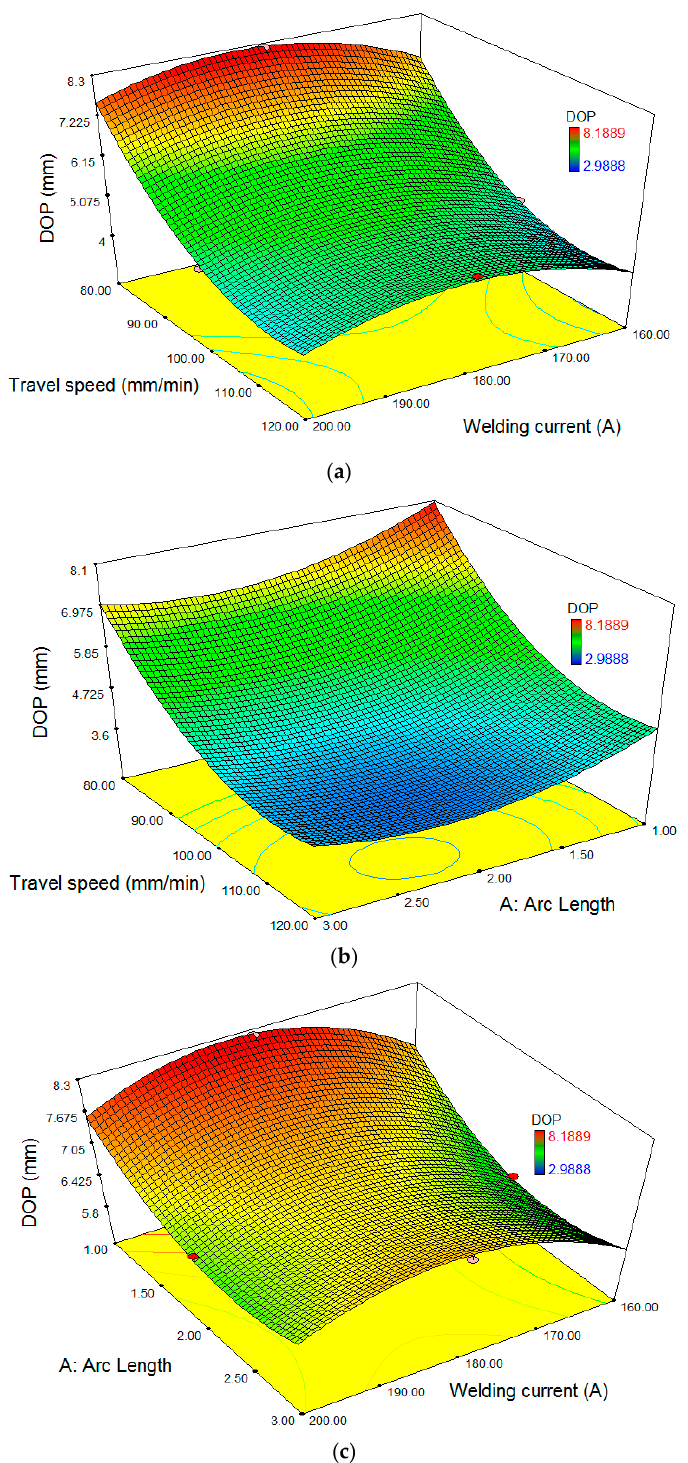
Figure 5. 3D surface plots for DOP at constant ( a ) arc length of 1 mm; ( b ) welding current of 192 A; and ( c ) travel speed of 80 mm/min.